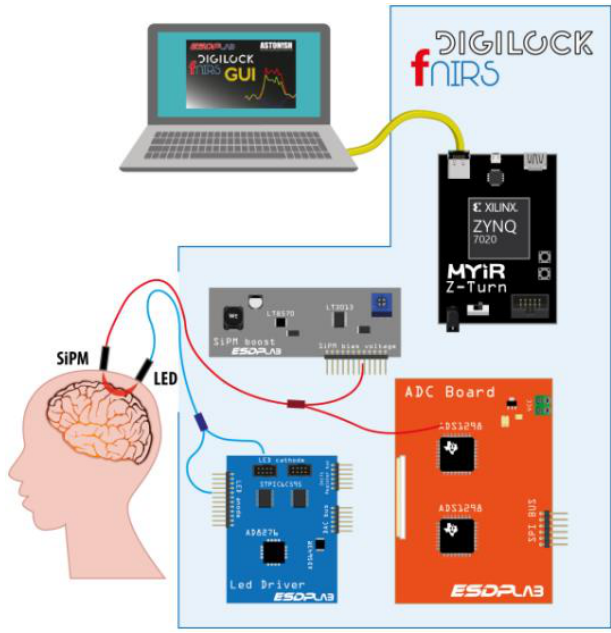
Figure 10. Block diagram of the DigiLock system. Reproduced from reference [61].